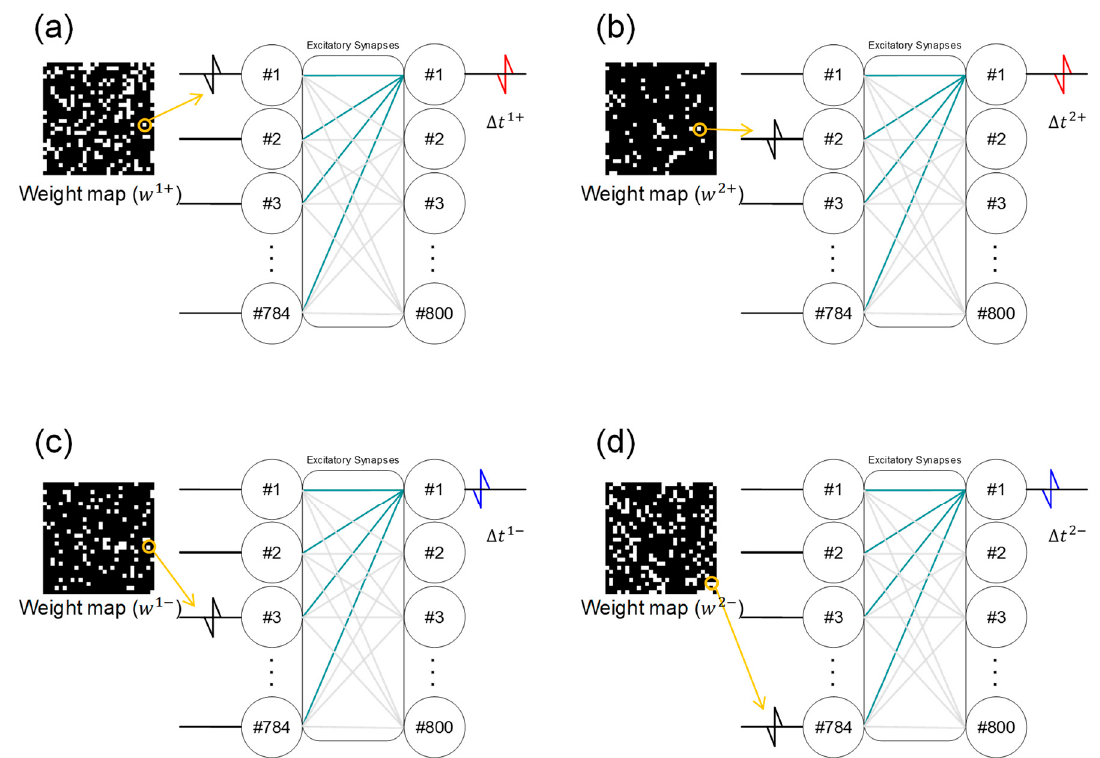
Figure 6. Illustration of the weight mapping process by STDP. The extracted weight map is applied as the voltage inputs. At the same time, a teaching signal with the timing difference obtained from STDP characteristic is applied to the G2 line of the neuron. Then, the weights connected to the neuron are transferred sequentially with the value of w 2 − , w 1 − , w 1 + , w 2 + .